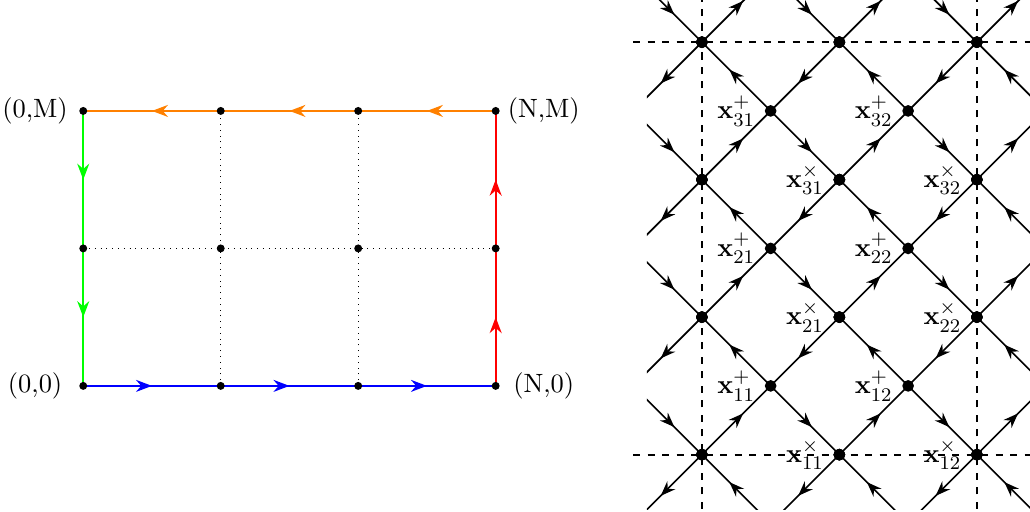
Figure 5 . Left: Newton polygon for ( N; M ) = (3 ; 2). Zig-zags from (cid:12)gure 6 as elements of torus (cid:12)rst homology group are drawn by colored arrows. Right: Poisson quiver. It is drawn on the torus, so vertices lying on left-right and up-down sides have to be